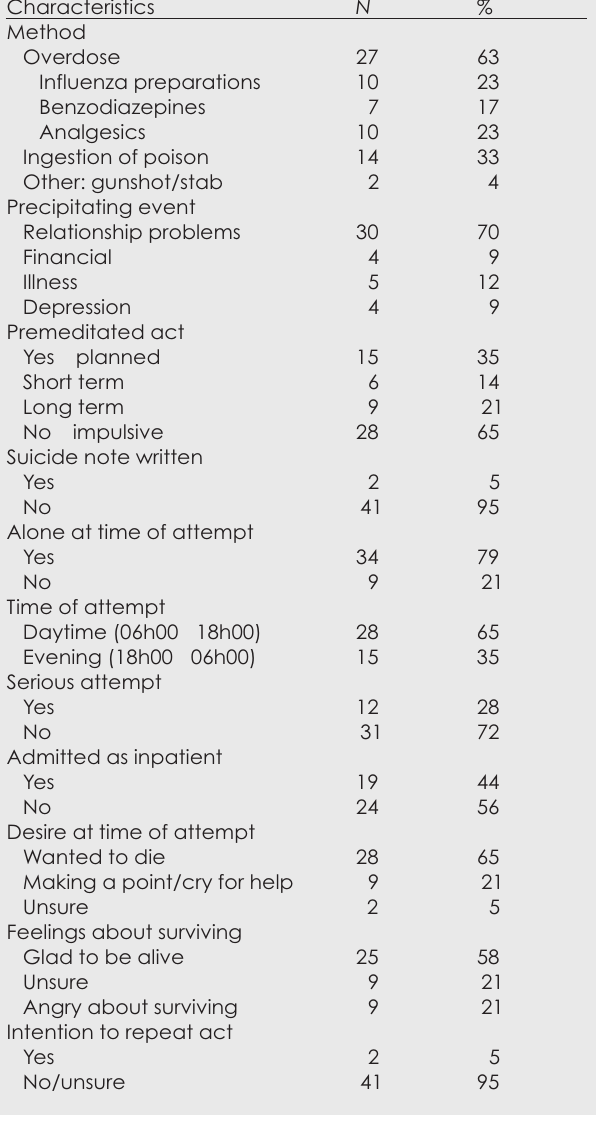
patients at Johannesburg Hospital